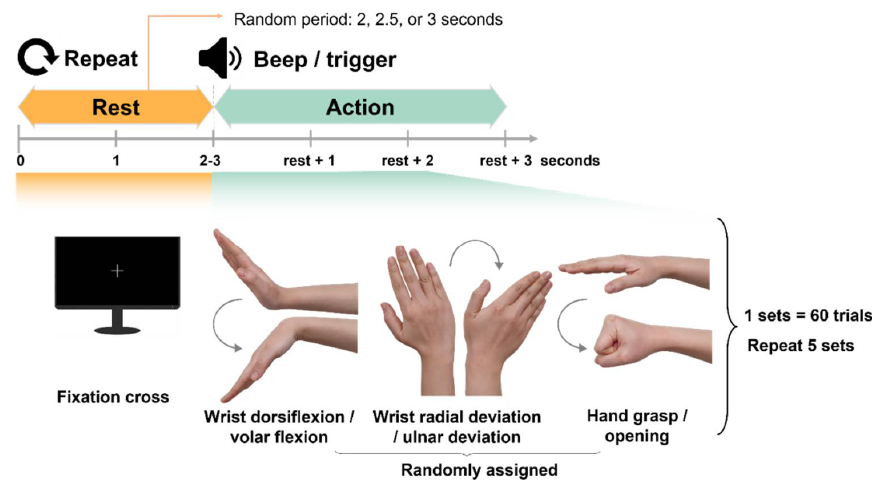
Figure 1. Schematic of experimental protocol based on two of six wrist and hand movements. Sixty-four (64) EEG signal channels were acquired from ANTneuro’s EEGO mylab (ANT Neuro, Enschede, The Netherlands) at a sampling rate of 500 Hz as shown in Figure 2. Then, using the same equipment, EMG signals were obtained at a sampling rate of 500 Hz for determining wrist and hand movements from four muscles of both arms: flexor carpi ulnaris, extensor digitorum communis, palmaris longus, and extensor carpi radialis. Before positioning the EMG electrode, the subject’s skin was washed with alcohol. We used Ag/AgCl disc electrodes with a diameter of 19mm (Catalog No. 019-400400, Natus Medical Inc., Pleasanton, CA, USA), and placed an active electrode to the center of each muscle belly as suggested in the reference [28], and a reference electrode to the proximal tendon of the target muscle near the elbow joint.